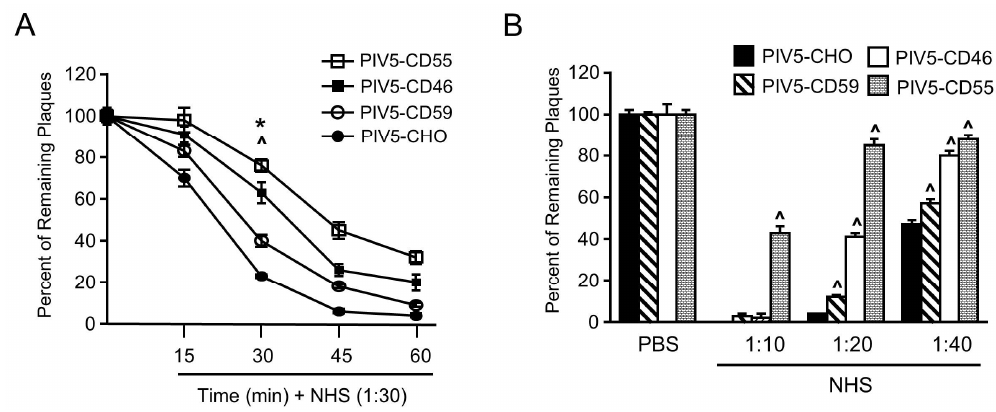
Figure 7. Relative contribution of CD55, CD46, and CD59 to resistance of PIV5 to complement-mediated neutralization. ( A ) One hundred PFU of PIV5 derived from the indicated CHO cell line was incubated with a 1:30 dilution of NHS for the indicated time points. Remaining infectivity was determined by using the plaque assay. The data are from three independent reactions and error bars represent standard deviation. ^ p < 0.01 when comparing CHO-CD46, CHO-CD55, or CHO-CD59 cell-derived PIV5 to CHO control cell-derived PIV5 at 30 min time point. * p < 0.01 when comparing CHO-CD46 or CHO-CD55 cell derived PIV5 to CHO-CD59 cell derived PIV5 at a 30 min time point. ( B ) One hundred PFU of PIV5 derived from indicated cell lines was incubated with the indicated dilutions of NHS for 30 min. Remaining infectivity was determined by plaque assay. ˄ p ˂ 0.01 when comparing